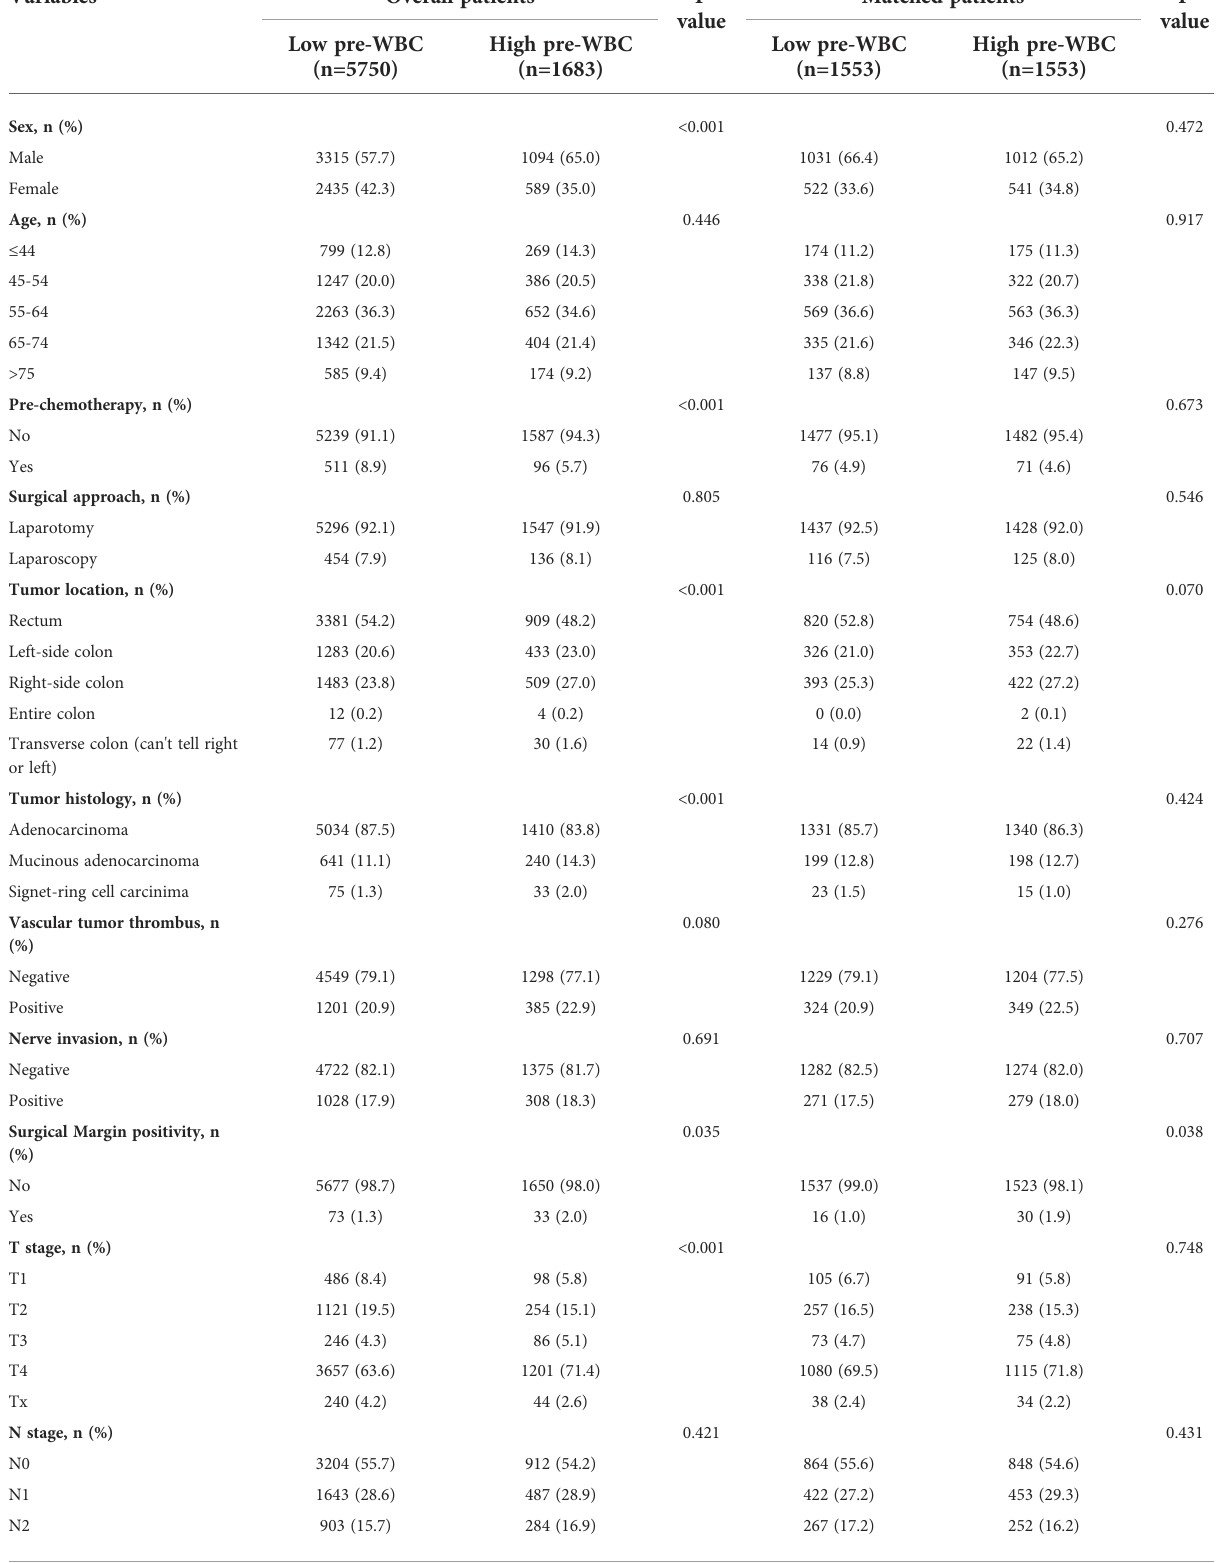
TABLE 1 Patients baseline Characteristics in the total study cohort and the propensity score matched